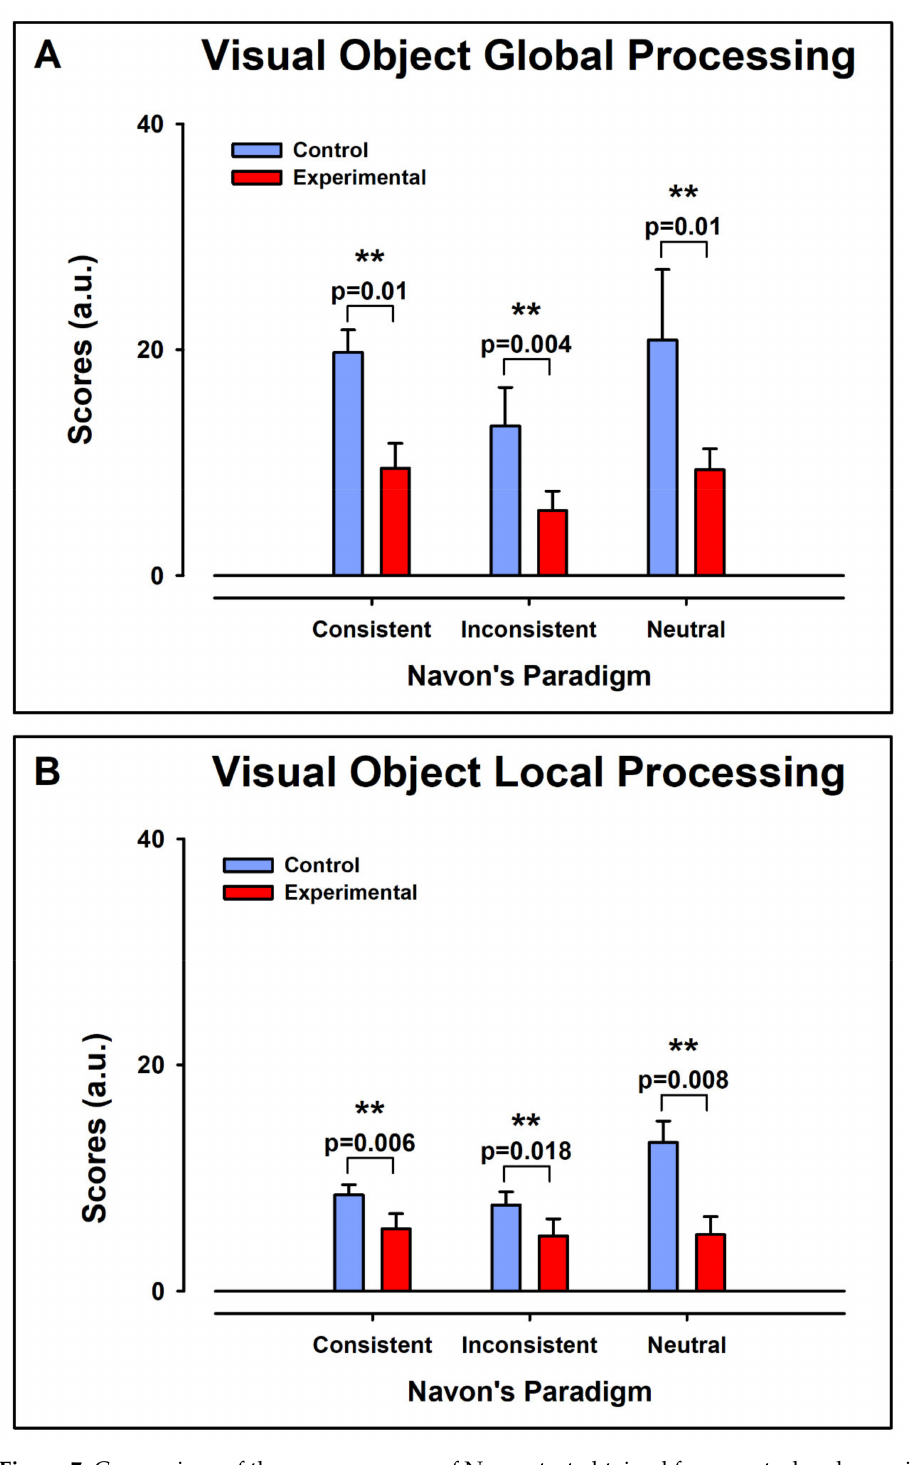
Figure 7. Comparison of the average scores of Navon test obtained from control and experimental group. ( A ) Scores for Global Aspect Recognition for consistent, inconsistent, and neutral stimulus. ( B ) Scores for Local Aspect Recognition for consistent, inconsistent, and neutral stimulus. Note that in all cases there was a significant decrease in the scores of the experimental group. p < 0.01 is marked with